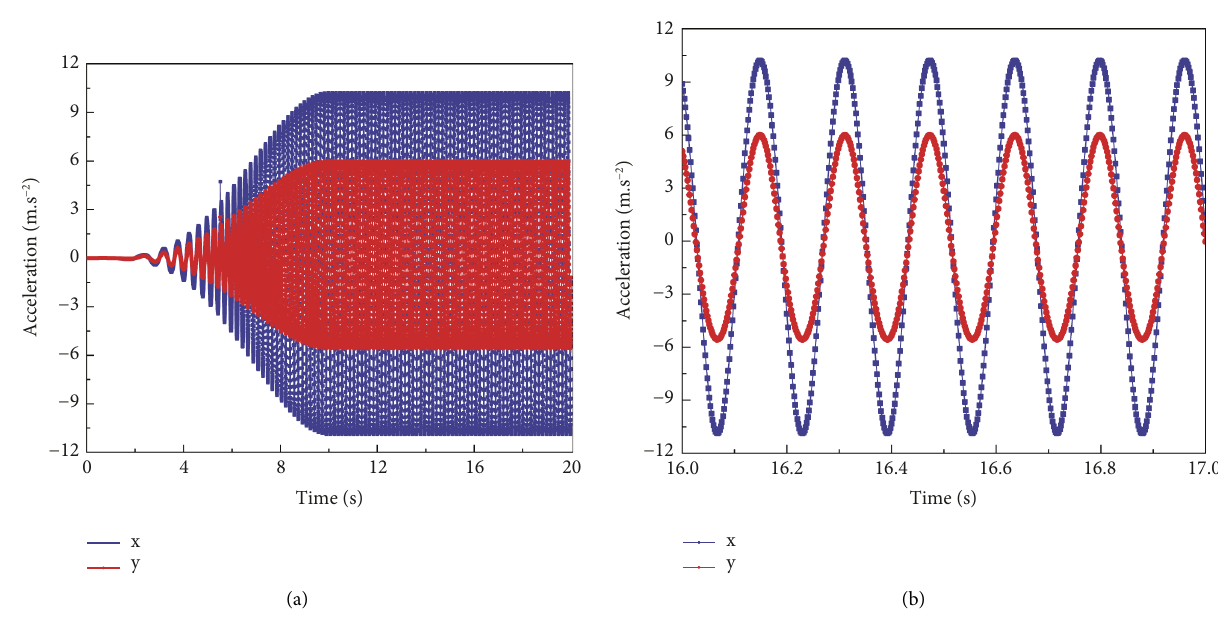
Figure 6: Time-responses of the velocity about the NCDS.